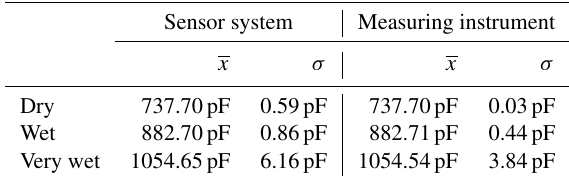
Figure 8. Experimental results of the capacitance against three dif- ferent conditions for the comparison of the sensor system and the measuring instrument. Table 3. Mean and standard deviation of the sensor system and the measuring instrument for three different